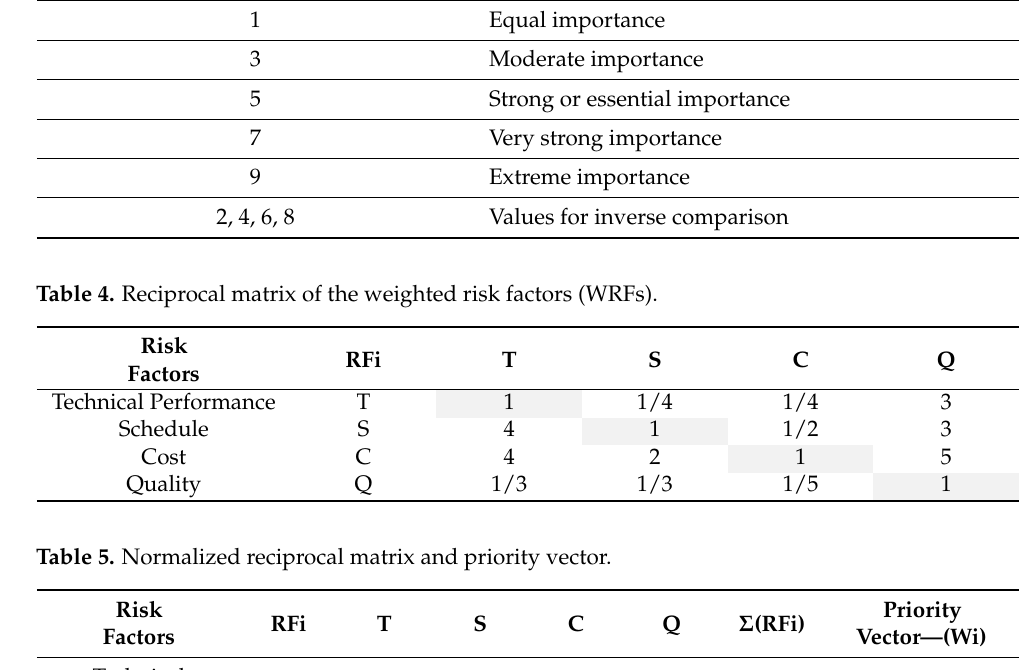
Table 3. The scale of pairwise comparison values ([93]).